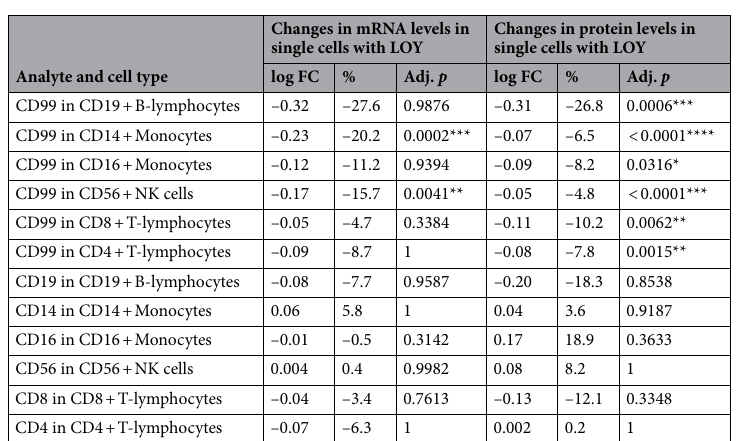
Table 1. Reduced abundance of immunoprotein CD99 in leukocytes lacking chromosome Y. Quantification of mRNA transcripts and seven cell surface proteins (CD99, CD19, CD14, CD16, CD56, CD8 and CD4) in single cells using CITE-seq. LOY associated changes was identified by comparing the abundance of transcripts and proteins in LOY cells compared with normal cells. "log FC" is the observed log fold change in abundance and "%" show the LOY associated changes as percentages. The "Adj. p " refers to Benjamini–Hochberg corrected p -values in statistical models adjusted for relevant confounders and asterisks denote level of